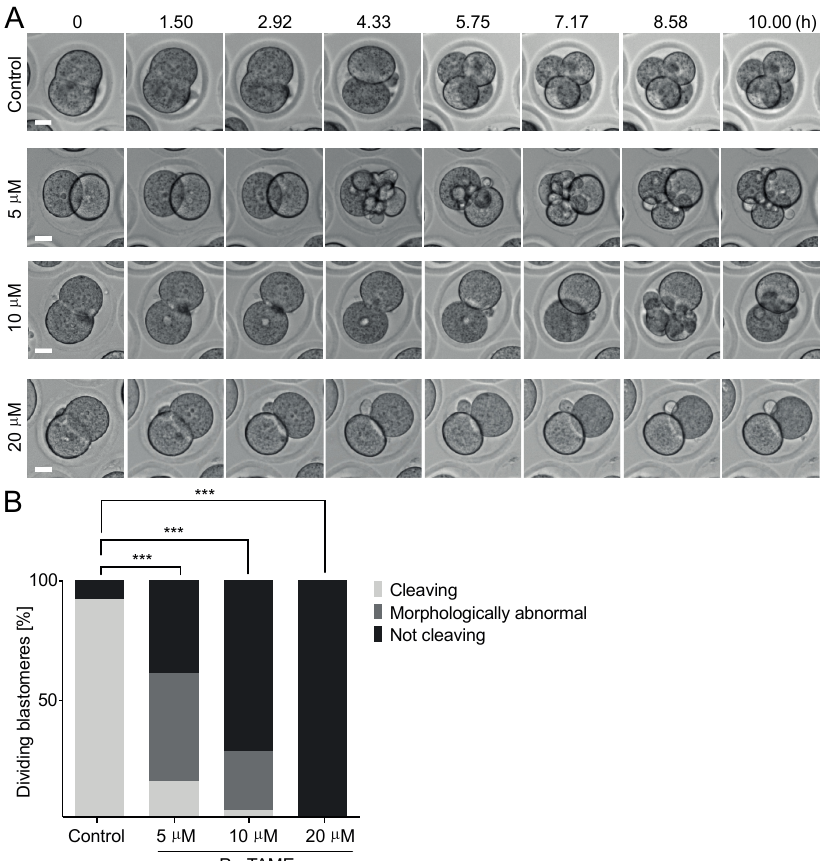
Figure 2. The impact of proTAME on the mitotic division of mouse two-cell embryos. ( A ) Frames from a time lapse microscopy experiment showing the cleavage of the untreated mouse embryo and embryos treated with 5 μ M, 10 μ M and 20 μ M proTAME. Scale bar: 20 μ m. ( B ) The frequency of cleaving, morphologically abnormal and not cleaving blastomeres was scored in control embryos ( n = 60), embryos treated with 5 μ M ( n = 58), 10 μ M ( n = 60) and 20 μ M ( n = 60) proTAME. In the control group, 92% of blastomeres were cleaving with no morphological abnormalities, and 8% of blastomeres were not dividing. In 5 μ M proTAME, 15% of blastomeres were cleaving with no morphological abnormalities, 45% of blastomeres showed morphological abnormalities and 40% of blastomeres were arrested. In 10 μ M proTAME, 3% of blastomeres were cleaving, 25% of blastomeres showed morphological abnormalities and 72% of blastomeres were arrested. In 20 μ M proTAME, 100% of blastomeres were arrested. Data were collected in two independent experiments. The difference between the control group and 5 μ M, 10 μ M, and 20 μ M proTAME is statistically significant ( α < 0.05; *** p < 0.0001).